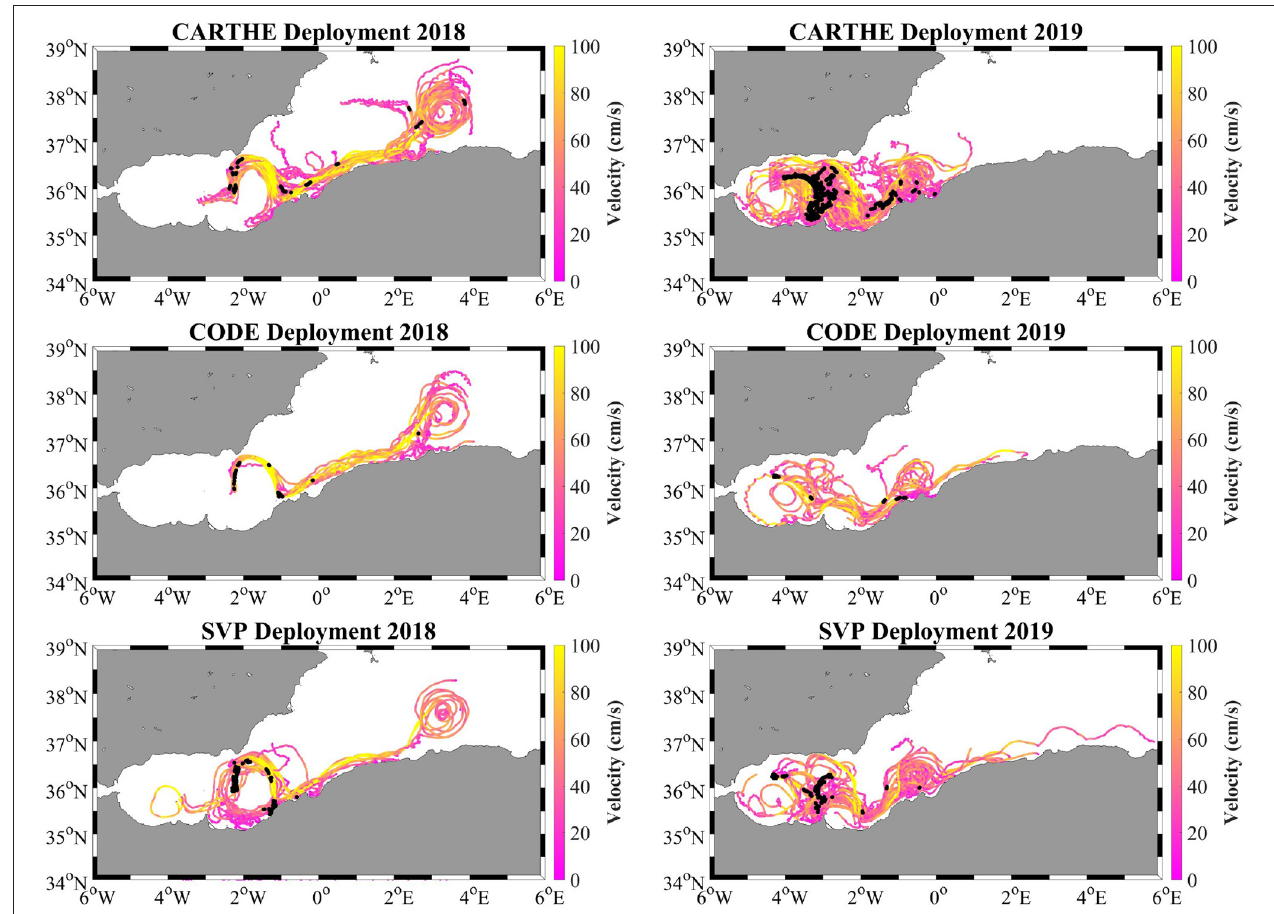
FIGURE 5 | Trajectories of drifters CARTHE (top) , CODE (middle) , and SVP (bottom) during the experiments 2018 (left) and 2019 (right), color coded with drifters’ speed. Black dots represent the spatial distribution of triplets in the range (4–6) km for each type of drifter in each year.